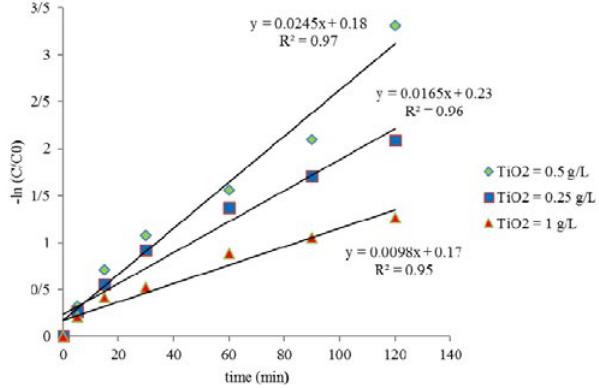
Fig. 7. Effects of TiO 2 amount on degradation kinetics(CLM=2 g/l,pH=5)